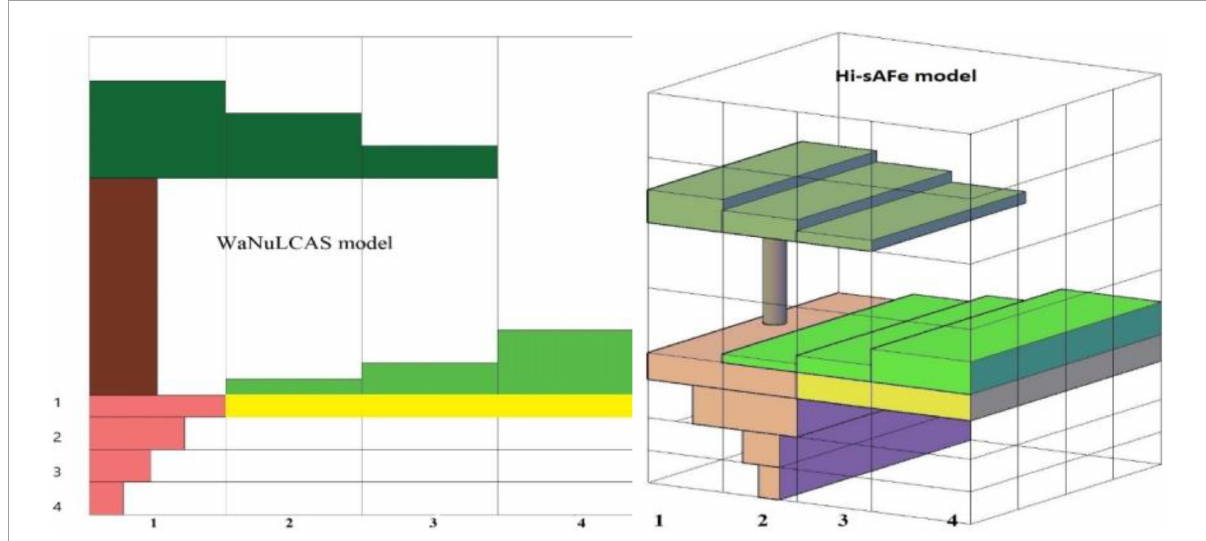
FIGURE1 The WaNuLCAS described by Van Noordwijk and Lusiana (1998) comprises four root zone depths (vertical zones) and four distances from the tree (horizontal zones) and the same four layers are included above ground for light. Hi-SAFE (3D) model zones represent the canopy (dark green color), distance from a tree (light green) and below ground, soil, and root (dark purple) (Dupraz et al.,